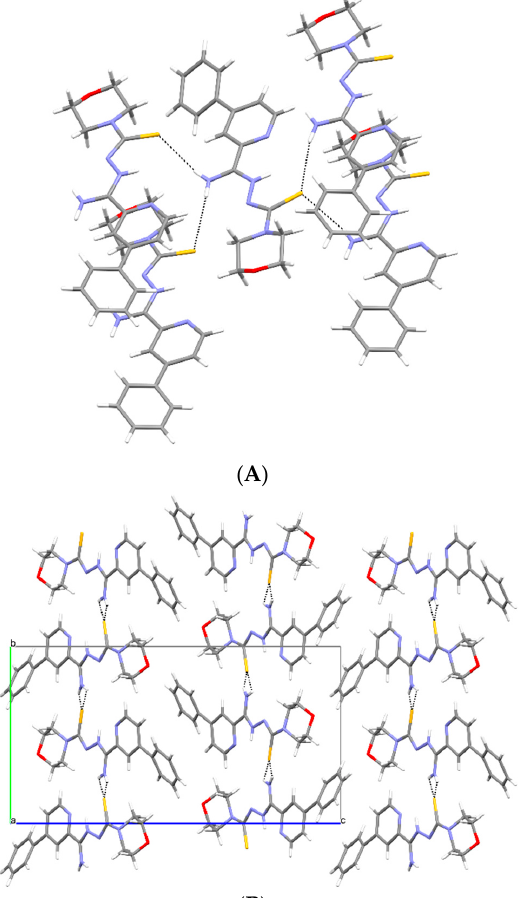
Figure 9. ( A ) Intermolecular hydrogen bonds in 1b . ( B ) The packing of molecules in 1b (a, b, c—unit